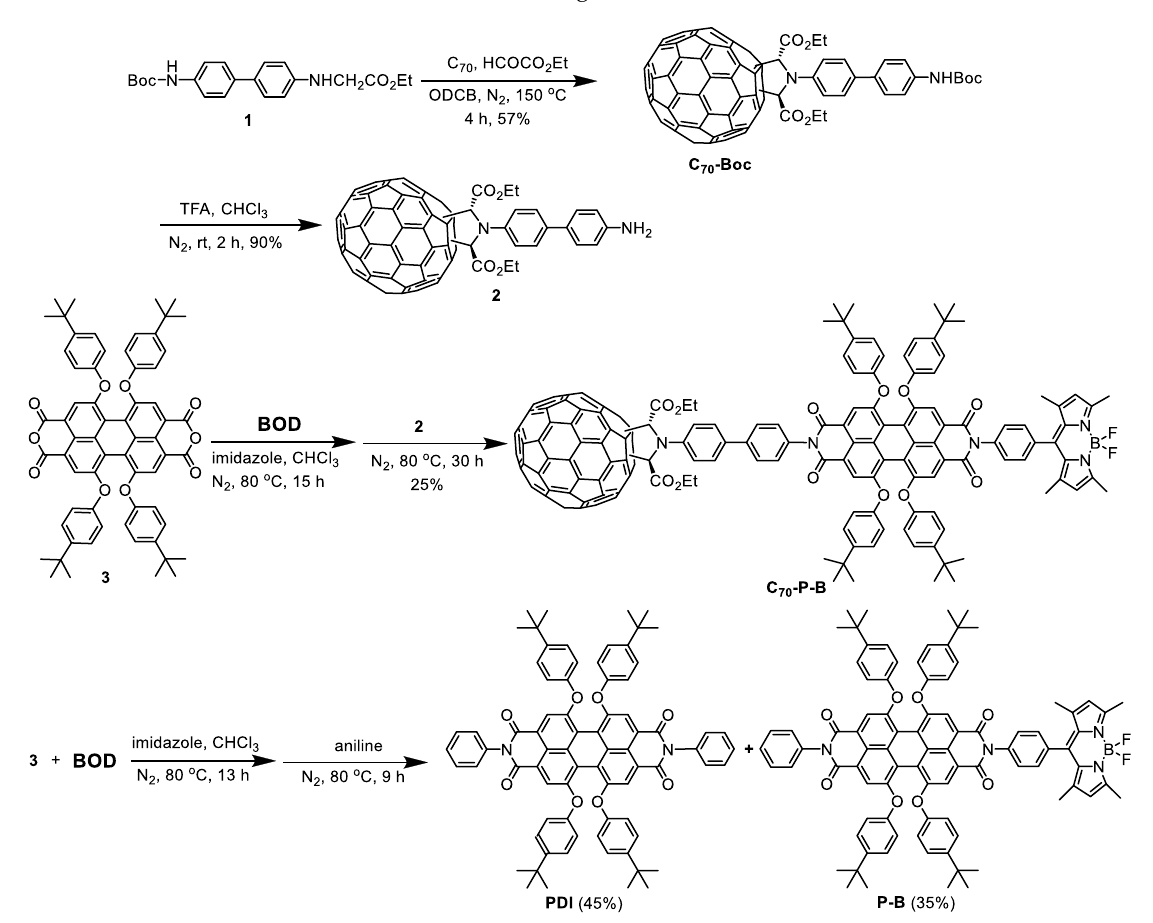
Figure 1. Molecules synthesized and studied in the present